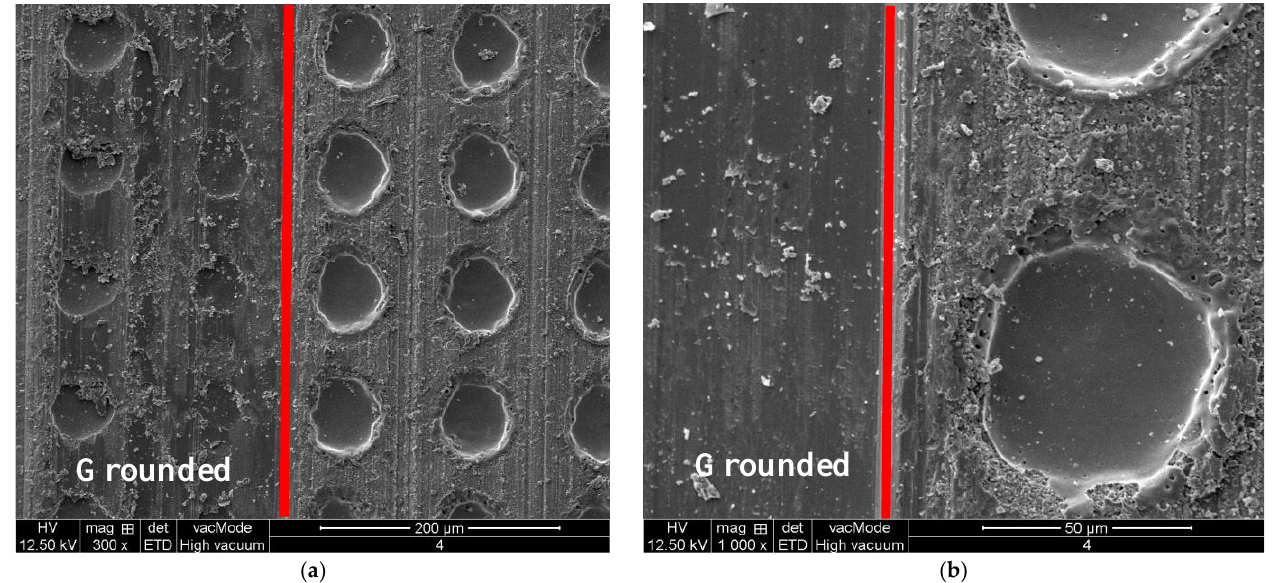
Figure 11. SEM microtopography of the lasered surface which is half grounded. ( a ) Partially grounded. ( b ) All grounded.